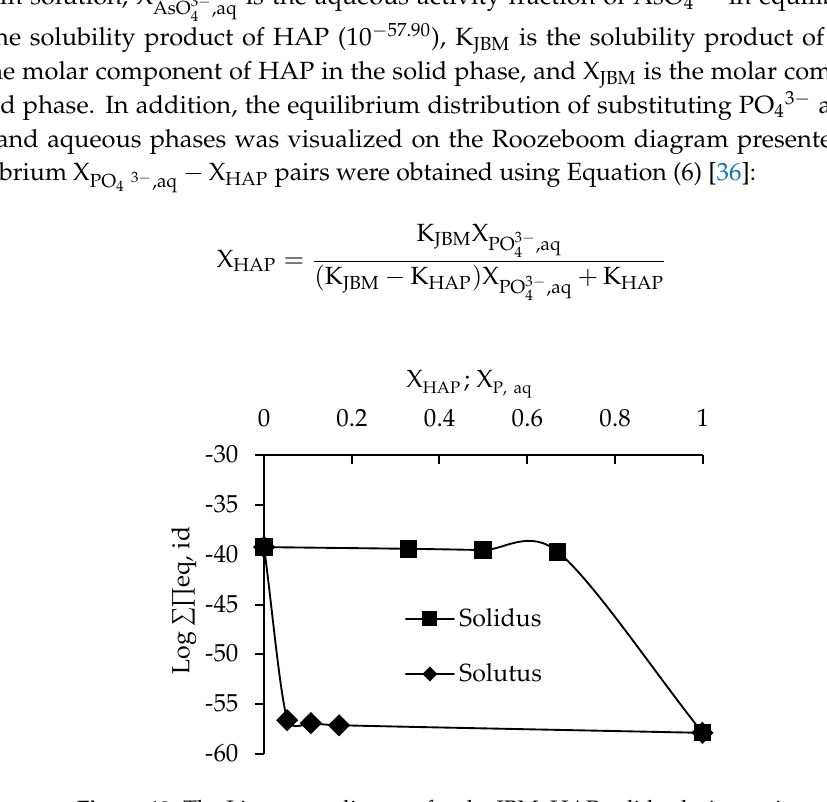
Figure 12. The Lippmann diagram for the JBM–HAP solid solution series.